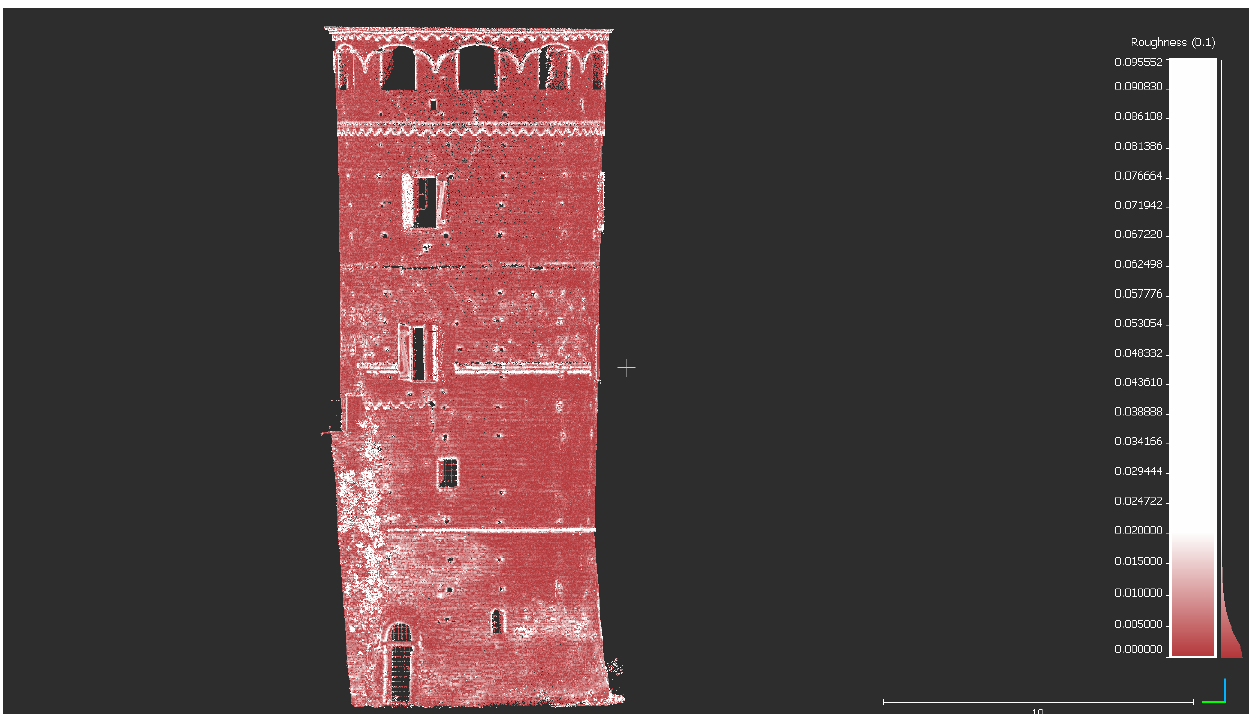
Figure 27. Roughness analysis of Trimble SX10 data: RMSe 0.009 m; standard deviation 0.007 m. White points are related to roughness and noise record.